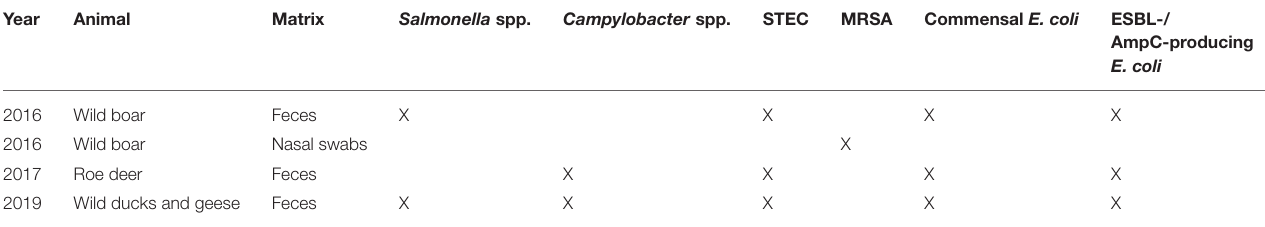
TABLE 1 | Overview of prevalence and resistance studies carried out for wildlife in the German Zoonoses-Monitoring in 2016, 2017, and 2019. Year Animal Matrix Salmonella spp. Campylobacter spp. STEC MRSA Commensal E. coli ESBL-/